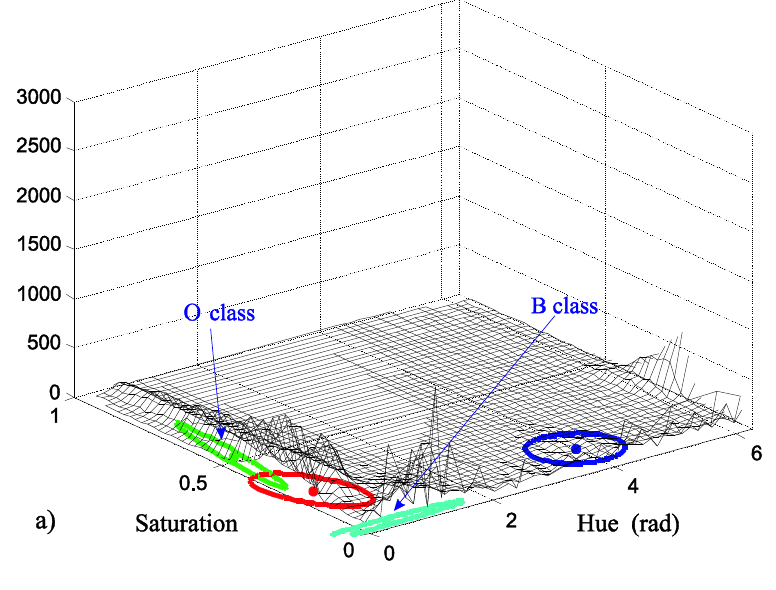
Figure 11. Example of 2D histograms in the HS plane for the original image I and injected image I . (a) Original image histogram, (b) injected image histogram. The class i redistribution in the injected image when compared with the original image can be observed. In the image I , an isolation of the main scene classes (O and B) can be visually i appreciated, as well as a shape closer to the Gaussian